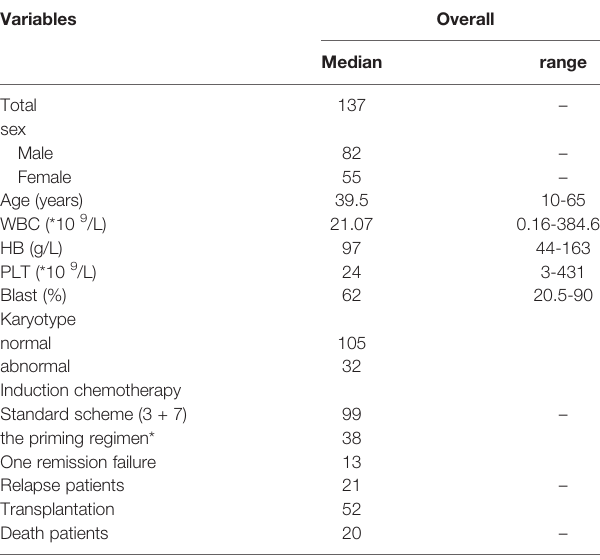
TABLE 1 | Clinical characteristics of patients with